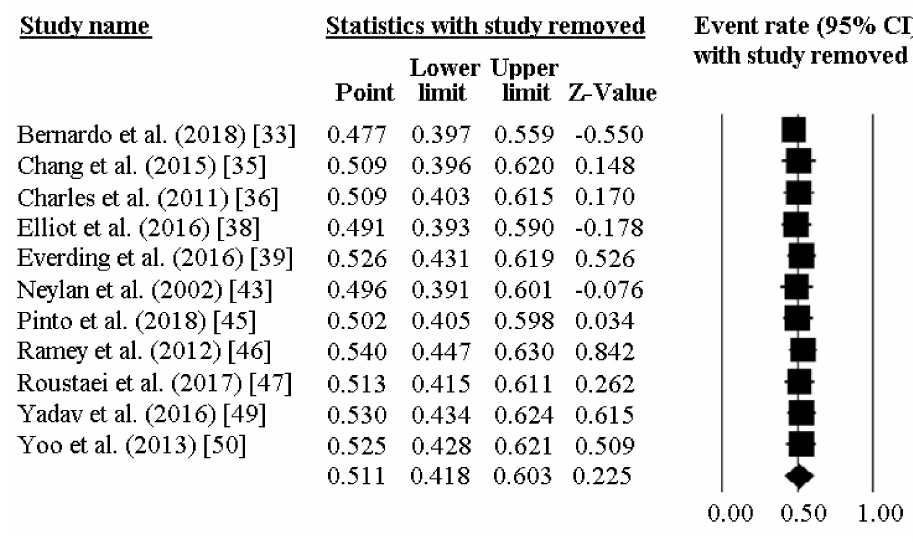
Figure 3. Sensitivity analysis for the prevalence of low sleep quality in police officers, showing stability and reliability of the